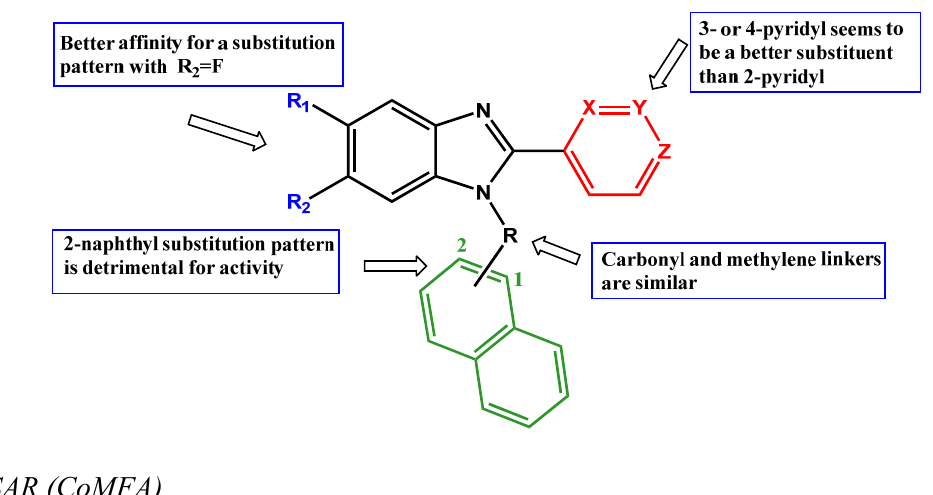
Figure 5. Structure-activity relationships.